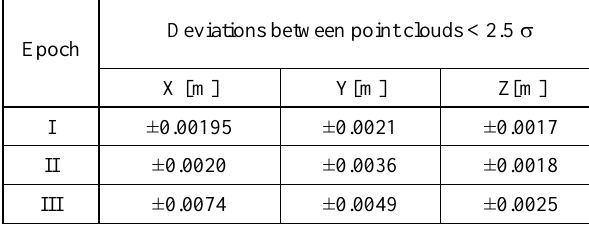
Table 5. The mean values of deviations smaller than 2.5 